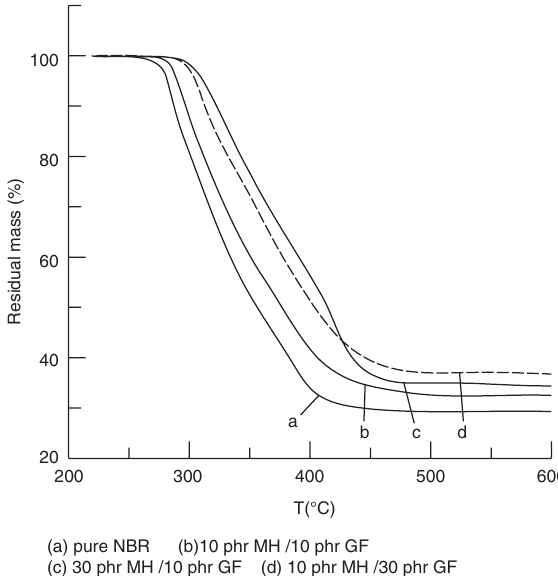
Figure 5 Shore A hardness curves for the nano MH/GF/NBR com- posite material. Figure 6 Residual mass of the MH/GF/NBR composite material.